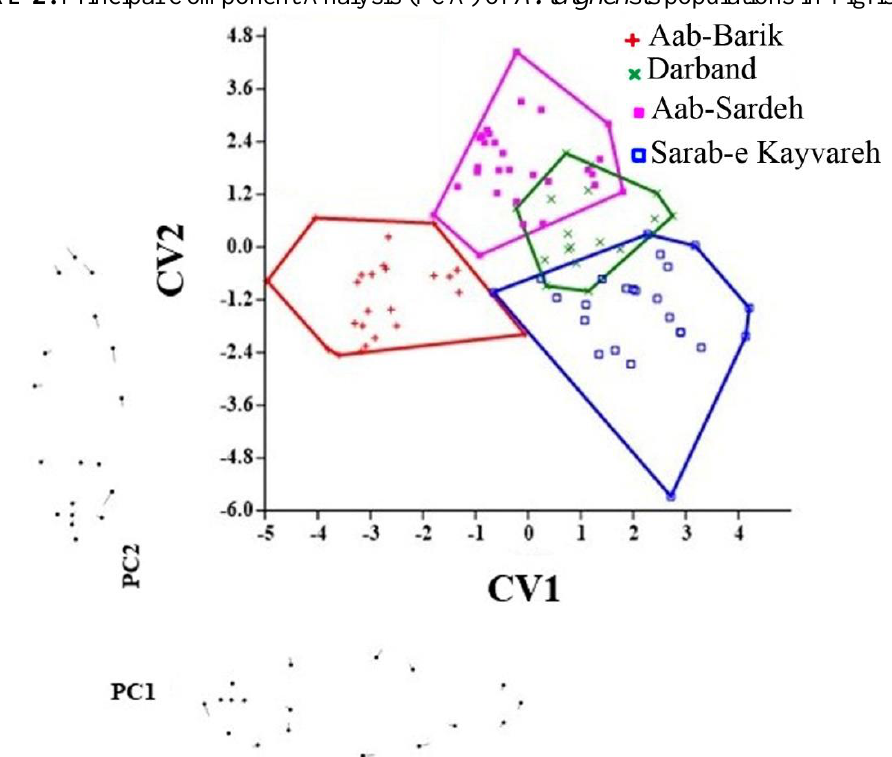
F IGURE 3. Canonical Variance Analysis (CVA) of A. idignensis populations in Tigris River Drainage, Persian Gulf Basin and TPS-deformation grid along the CV1 and